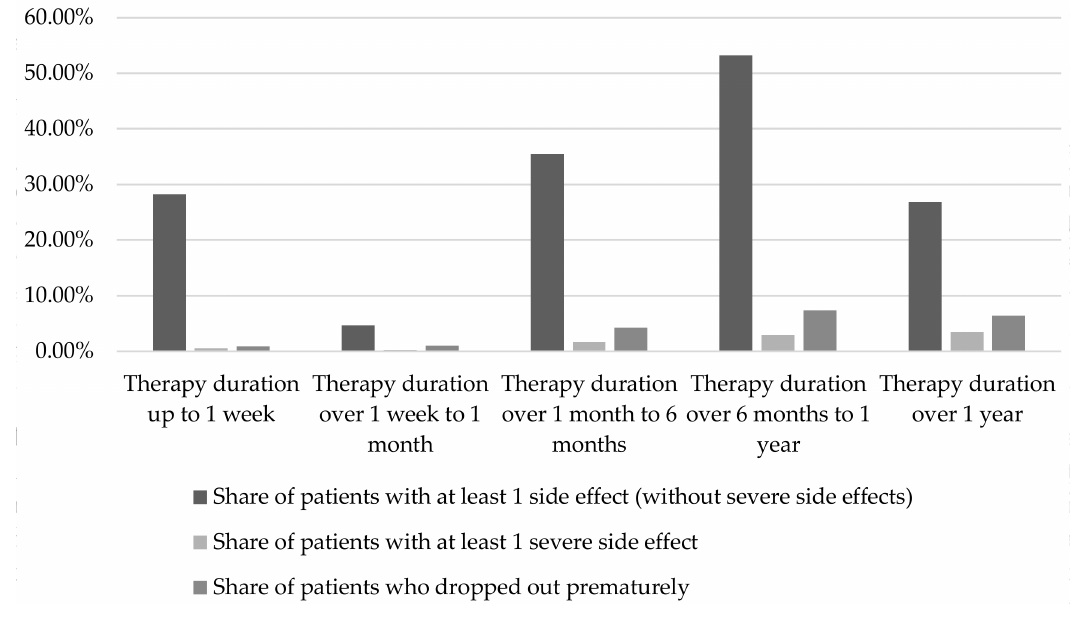
Figure 2. Occurrence of adverse events in dependence on therapy duration (n (therapy duration up to one week) = 332; n (therapy duration over one week to one month) = 6525; n (therapy duration over one month to six months) = 3170; n (therapy duration over six months to one year) = 1297; n (therapy duration over one year) = 917; per therapy period differentiation between patients with at least one side effect (column 1), patients with at least one severe side effect (column 2), patients who dropped out of the study prematurely (column 3)) [2,8–15,17–52].